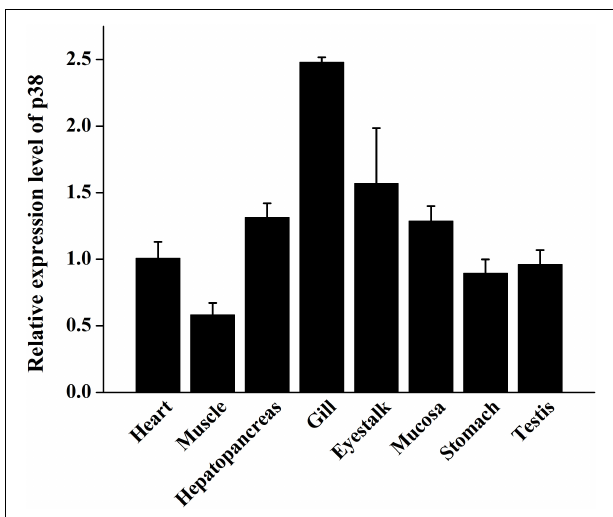
FIGURE 5 | qRT-PCR analysis of the PtP38 transcription in different tissues of the untreated crabs. Using GAPDH as an internal reference, the relative expression level of PtP38 in the heart was set to 1. Three repeated experiments were performed for each sample. The results were expressed as means ± standard